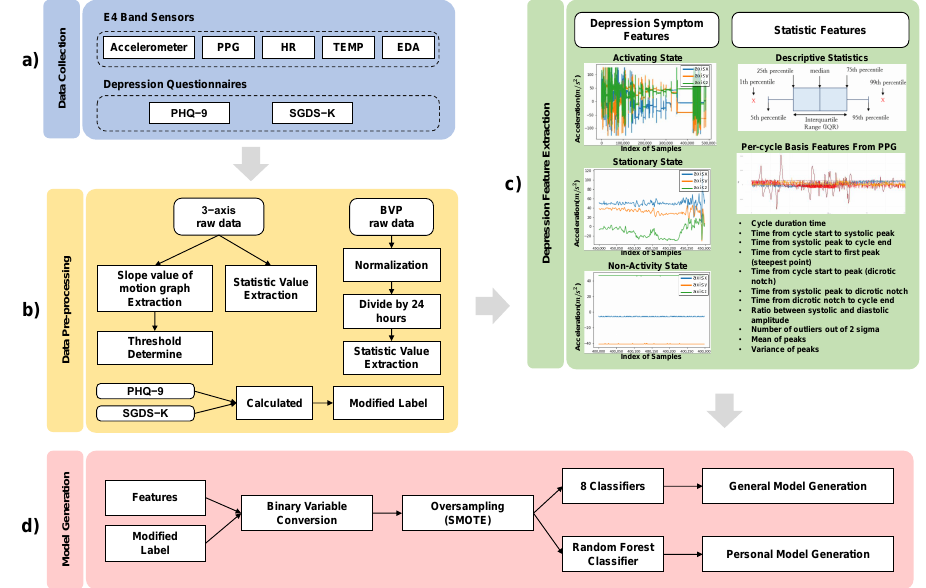
Figure 1. The model generation process proceeds sequentially from ( a ) to ( d ). ( a ) refers to collected biometric sensor data and questionnaire data. In ( b ), it refers to the pre-processing of the data collected in ( a ). The 3-axis accelerometer sensor data, BVP data, and questionnaire data, which are raw data of each sensor, are applicable. In ( c ), two types of features are extracted from data that has undergone pre-processing. These include features related to depression symptoms and statistical features. The general model and the personal model are generated from features and modified labels as shown in ( d